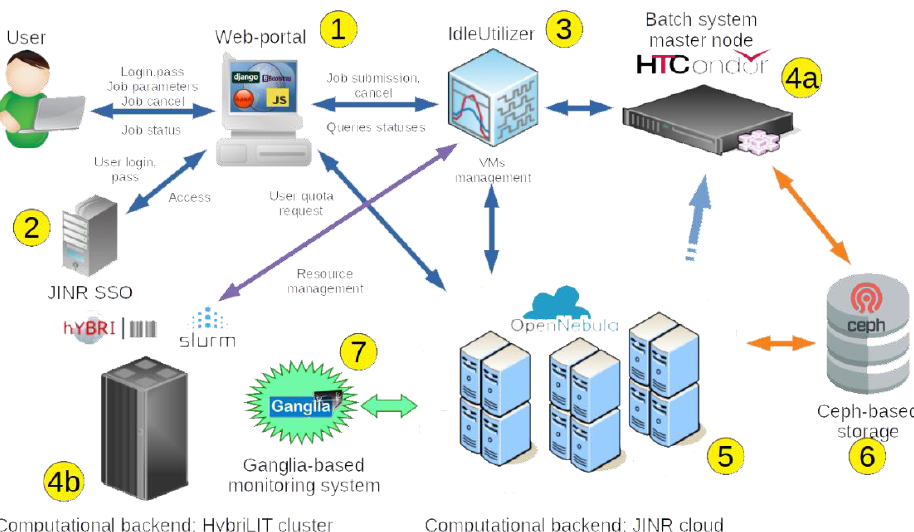
Fig. 1. A basic workflow schema and main components of the JINR SaaS